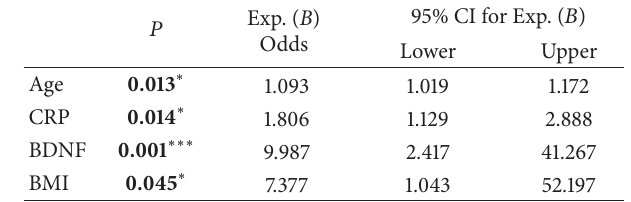
Table 2: Relationship between HOMA-IR, triglyceride levels, WBC levels, and BDNF in T2DM patients.